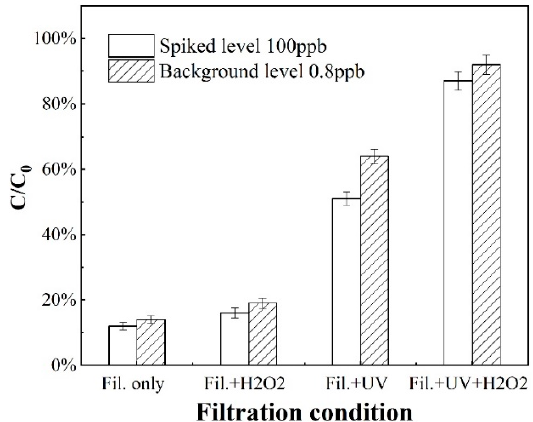
Figure 4. The SMX removal in initial and spiked toilet water under different degradation processes on catalyst-coated ceramic membrane. The background SMX concentration: 0.8 ± 0.05 ppb, spiked SMX concentration: 100 ppb. The UV 254 intensity was 401 µW·cm − 2 ; H 2 O 2 concentration was 10 mmol·L − 1 ; and the catalyst on the ceramic membrane was 2 µg·g − 1 . “Fil.” stands for filtration with a permeate flux of 10 LMH.